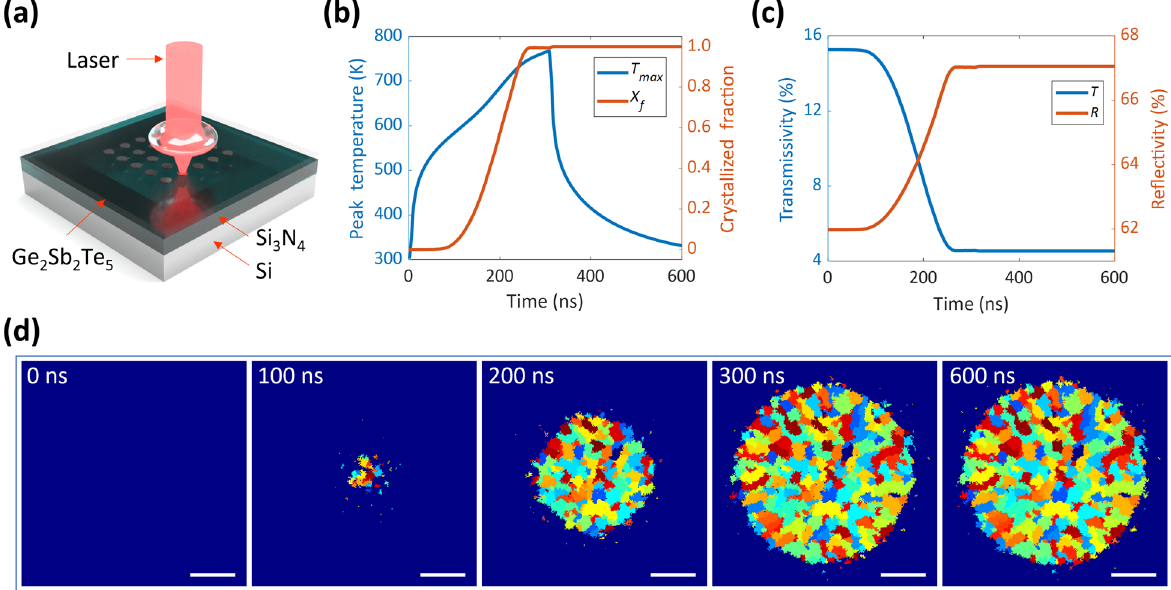
Fig. 2 Simulated crystallisation at 3.0 mW. a Schematic diagram of the Ge 2 Sb 2 Te 5 programmable optical stack. b The peak temperature ( T max ) and crystallised fraction ( X f ) versus time. c The transmissivity ( T ) and re fl ectivity ( R ) versus time. d The crystal microstructures of Ge 2 Sb 2 Te 5 fi lm at different time. Scale bar is 200 nm. system, the temporal waveform of the laser pulse is an isosceles We simulated the crystallisation and melting processes of trapezoid function with rise and fall time of 8 ns. Due to the amorphous Ge 2 Sb 2 Te 5 with a focused Gaussian laser beam. The thinness of the Ge 2 Sb 2 Te 5 layer, the divergence of the laser beam beam radius (1/e 2 intensity) was 600 nm and the peak power was changed from 0 mW to 5.0 mW, whilst the pulse duration was in the Ge 2 Sb 2 Te 5 was ignored. At the 660 nm laser wavelength, varied from 100 ns to 1000 ns. These parameters were chosen by the complex refractive indices of amorphous and crystalline considering the accessible parameters of our laser testing Ge 2 Sb 2 Te 5 are N a = 4.36 – 1.79 i and N c = 4.61 – 4.01 i , respectively 12 . system 48 , which will be used to compare the modelled and The crystallisation process of the programmable optical device measured change in transmission due to the laser pulse. In this was simulated using a 3.0 mW and 300 ns laser pulse. Fig. 2b and c